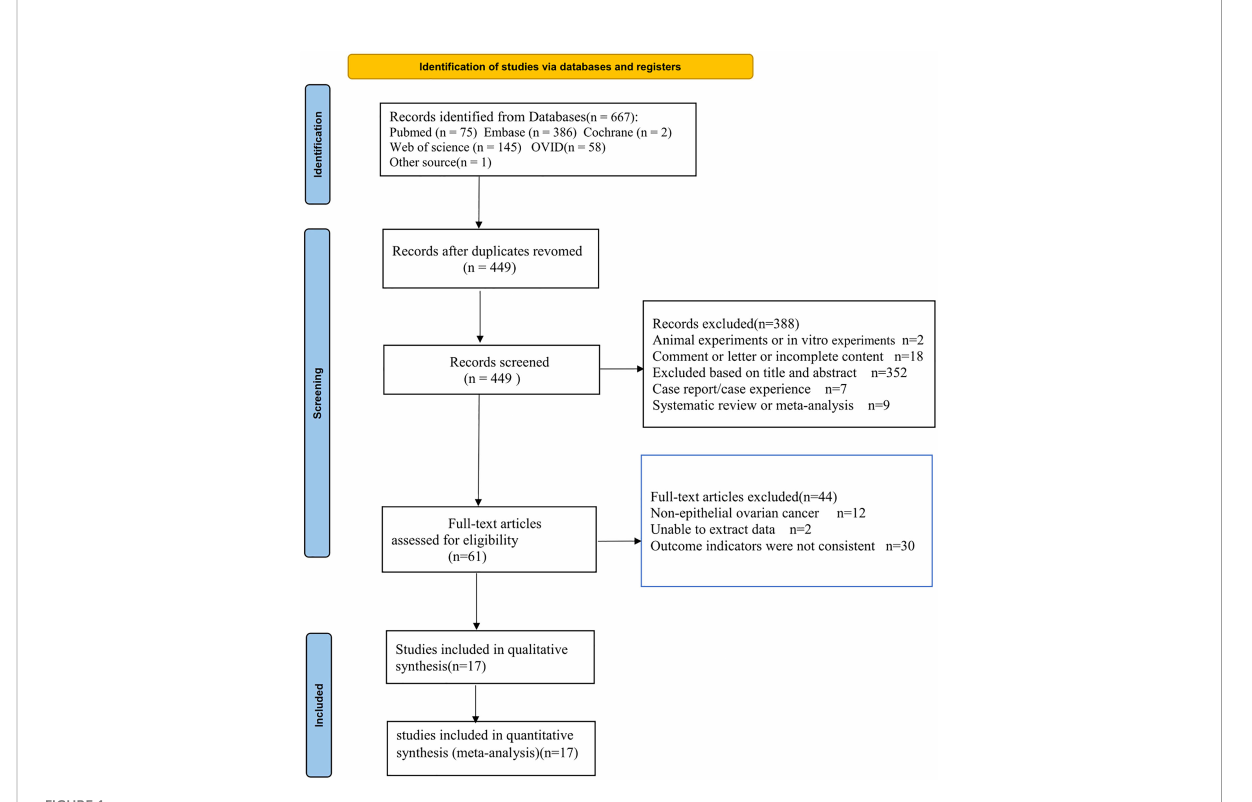
FIGURE 1 Flow diagram of studies selection